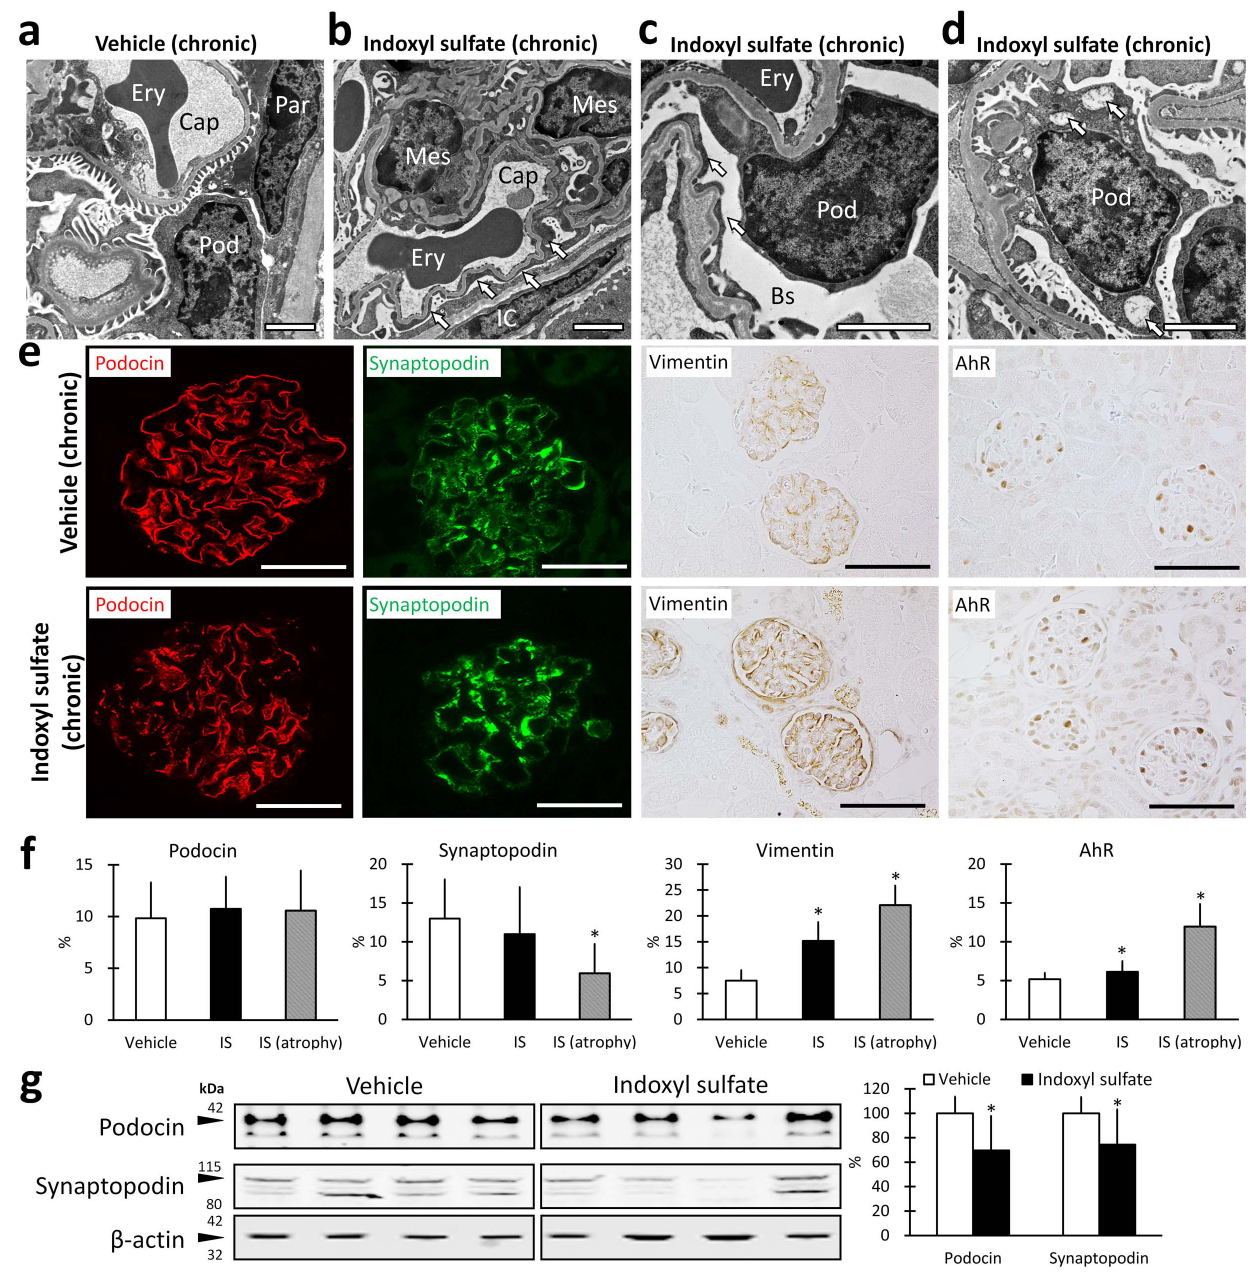
Figure 4. Indoxyl sulfate treatment induces podocyte injury in mice. FVB/N mice were exposed to vehicle or indoxyl sulfate (600 mg/kg, i.p.) for 8 w. Transmission electron microscopy images of glomeruli ( a–d ) demonstrate that indoxyl sulfate exposure is associated with wrinkled and partially collapsed glomerular basement ( b and c ) and focal podocyte (Pod) foot process effacement ( b and c , arrows). Electron-lucent materials were observed in the Bowman space (Bs) in the indoxyl sulfate-exposed mouse ( c ), and the podocytes contained cytoplasmic vacuoles, consistent with protein resorption droplets ( d , arrows). Ery denotes erythrocyte; Cap denotes capillary lumen; Par denotes parietal cell; and Mes denotes mesangial cell. Bars=1 m m. Representative images of immunostaining of renal cortices are shown ( e ), bars=20 m m. Histomorphometry of immune-positive glomerular area fraction that stained for podocin, synaptopodin, vimentin, and AhR in glomeruli are shown ( e , f ). n $ 3, mean 6 S.D. * denotes significant differences between the vehicle and indoxyl sulfate groups ( P , 0.05). A representative immunoblot for podocin, synaptopodin, and b -actin by using whole kidney lysate from kidneys lacking visible atrophy is shown ( f ); arrowheads indicate the predicted sizes of podocin (42 kDa), synaptopodin (100 kDa), and b -actin (42 kDa). The band intensities were quantified by performing image analysis; n=7, mean 6 S.D ( g ). * denotes significant differences between the vehicle and indoxyl sulfate groups ( P , 0.05).